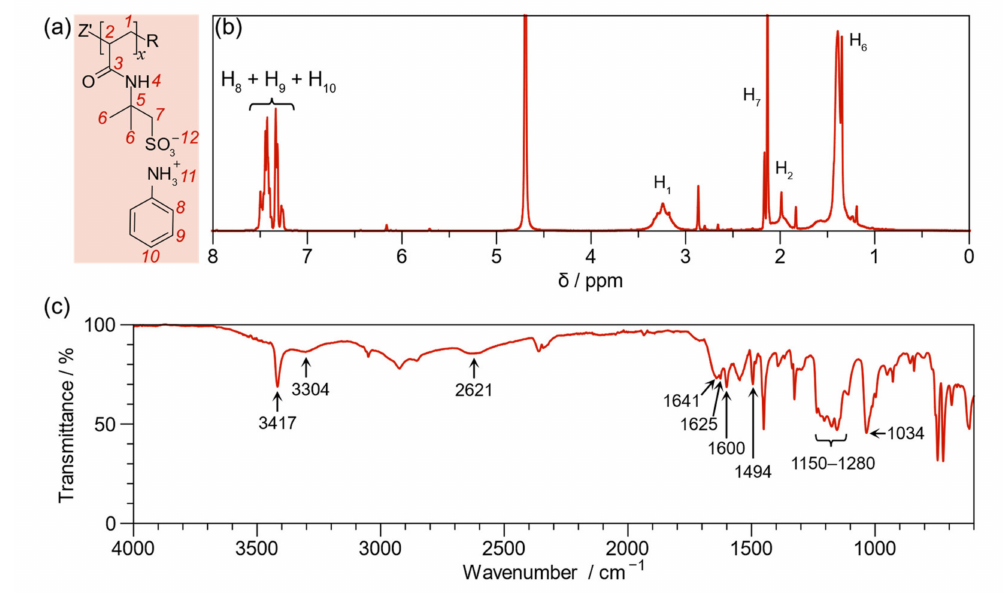
Figure 2. ( a ) Proton assignment of the poly(anilinium 2-acrylamide-2-methyl-1-propanesulfonate) (macro-RAFT) structure ( b ) 1 H NMR spectrum of macro-RAFT; ( c ) FT-IR of